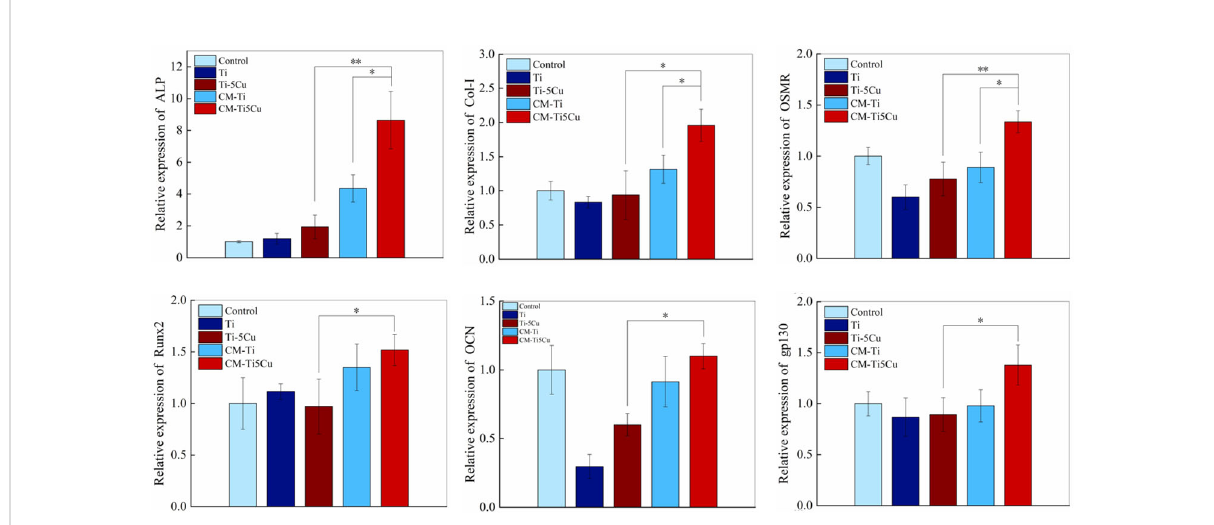
FIGURE 10 The expressions of osteogenic genes and OSM-related receptors genes of MC3T3-E1 cells after cultured with conditioned medium and material extracts for 7 days by RT-qPCR (n = 3; *p < 0.05 and **p <